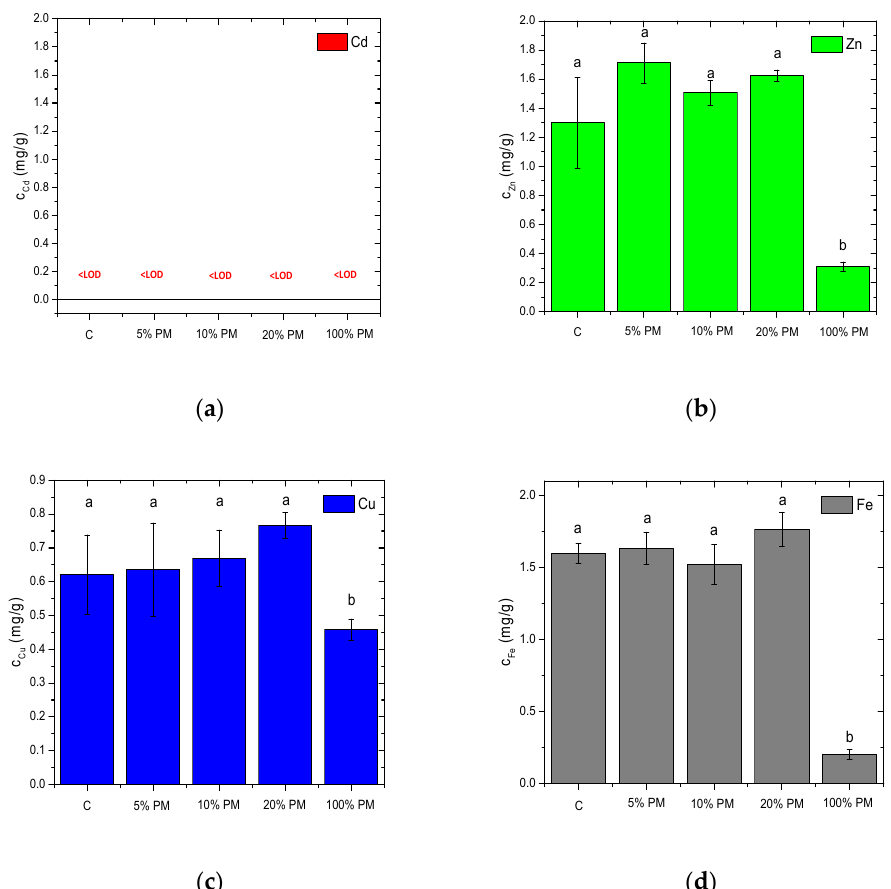
Figure 5. Concentrations of Cd ( a ), Zn ( b ), Cu ( c ) and Fe ( d ) quantified in dry biomass of Lactuca sativa lettuce after 60 days of cultivation at 60% water capacity, 12 h light/12 h dark, 22 ± 2 °C in unenriched garden substrate (C), substrate with 5% addition of PM (5% PM), substrate with 10% addition of PM (10%PM), substrate with 20% PM (10% PM) and in pure PM (100% PM). Different letters indicate statistical significance between additions to a given parameter based on the Tukey post-hoc test ( p < 0.001).